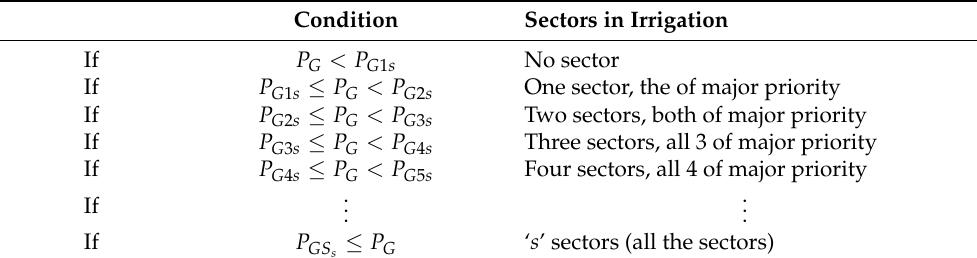
Table 4. Distribution conditions of generated power to demand power. P G is the effective power of the generator (supply matrix). P G1s , P G2s , P G3s and P G4s are the electrical powers demanded by the variator–motor pump–irrigation network system (column 4 of Table